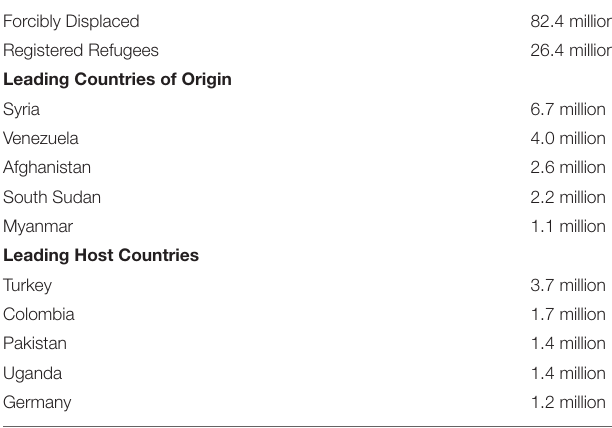
TABLE 1 | Global refugee